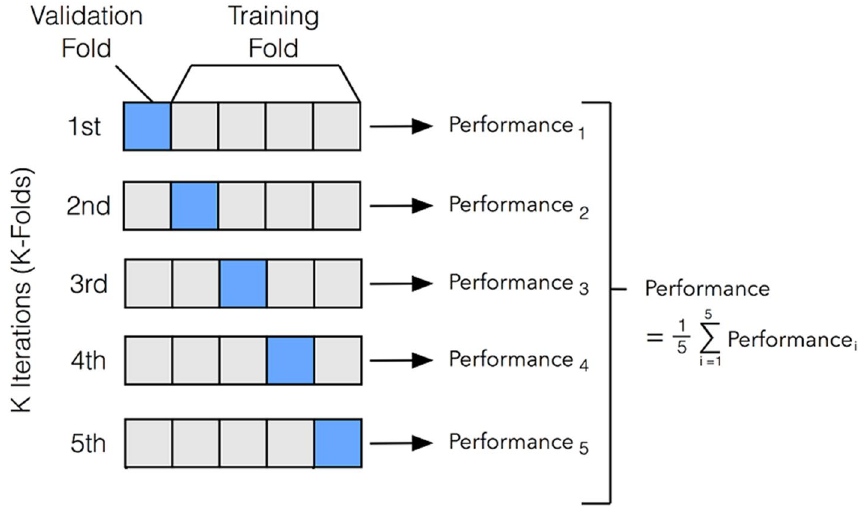
Figure 4. Ensemble voting system using fivefold